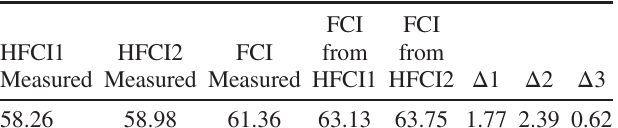
TABLE VII. Measured HFCI and FCI scores and predicted FCI scores. The predicted FCI scores are obtained by applying the linear conversions to the two measured HFCI scores at university C. The differences between the predicted FCI scores (from HFCI1 and HFCI2) and the measured FCI score are calculated and listed as Δ 1 and Δ 2 . The difference between the two predicted FCI scores are listed as Δ 3